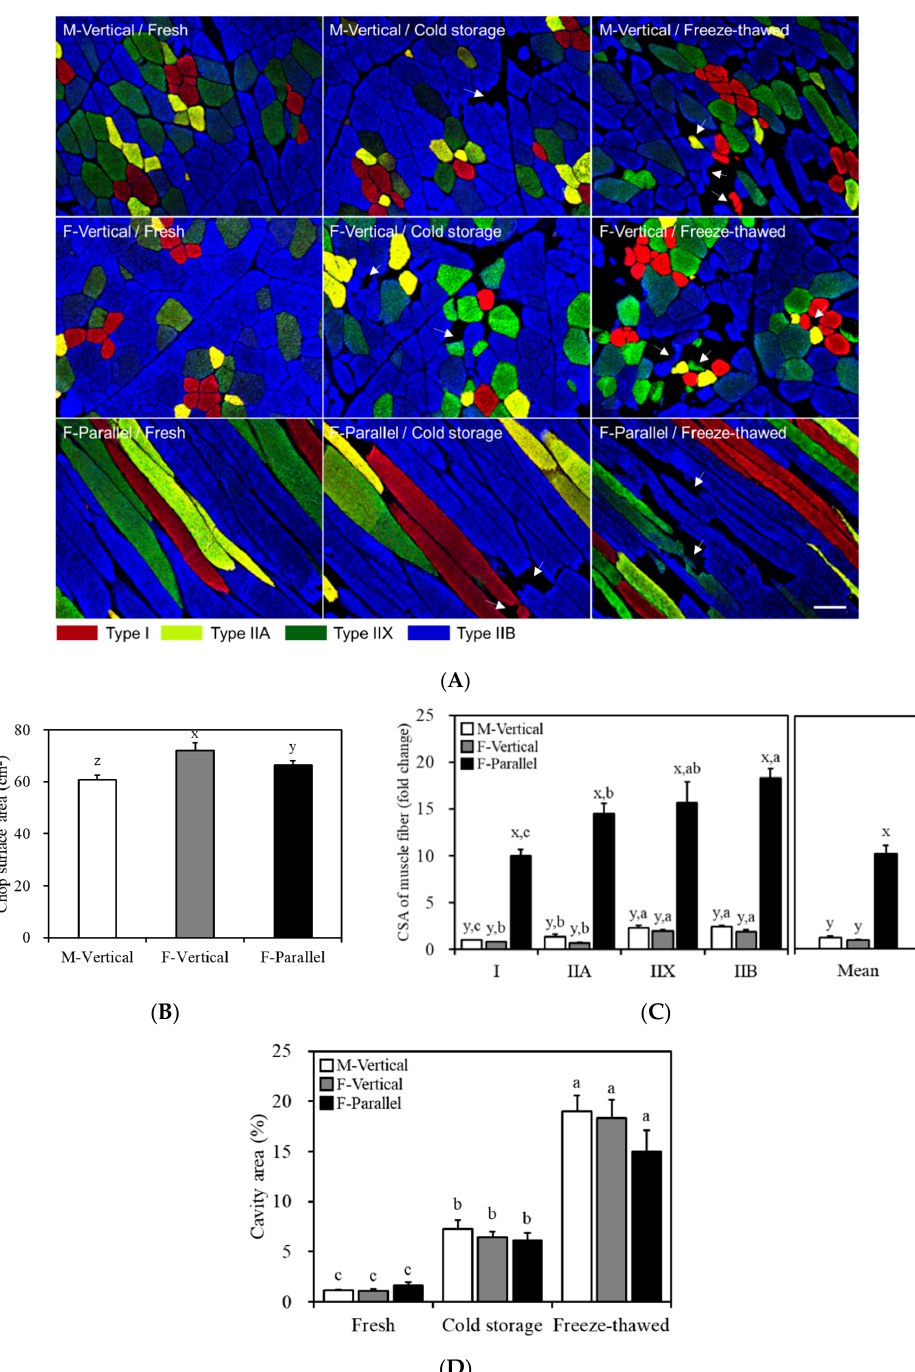
Figure 2. Immunohistochemical analysis and evaluation of chop surface area and muscle fiber characteristics. ( A ) Representative stained sections of pork loin chops cut in different directions: M-Vertical, cut vertical to the longitudinal direction of loin muscle; F-Vertical, cut vertical to the muscle fiber orientation; F-Parallel, cut parallel to the muscle fiber orientation. The merged images were obtained from three different sections incubated individually with antibodies, BF-35, SC-71, and BF-F3, specific for the four types (I, IIA, IIX, and IIB) of muscle fibers. Arrowheads indicate damaged muscle fibers. Bar indicates 100 µm. Evaluation of ( B ) surface area of pork loin chop, ( C ) cross-sectional area (CSA) of muscle fiber, and ( D ) cavity area. Fresh, at 1 day postmortem stored at 1 °C; Cold storage, stored at 1 °C for 7 days; freeze–thawed, frozen at − 20°C for 5 days and thawed at 1 °C for 2 days. x-z letters on the bar indicate significant difference ( p < 0.05) between pork cut groups. a-c letters on the bar indicate significant difference ( p < 0.05) between muscle fiber types or storage methods within the same cut group.